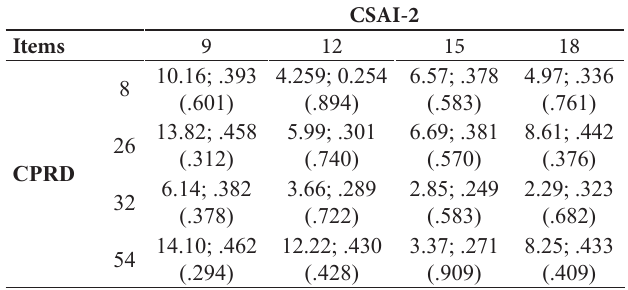
Table 4. Correlation of CSAI-2 and CPRD items on the variable self-confidence.